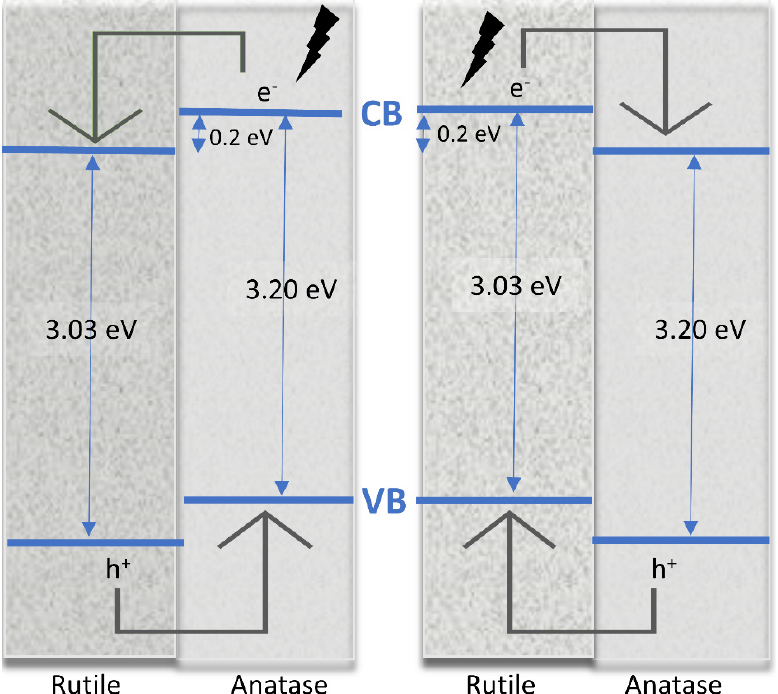
Figure 7. Two valence and conduction band alignment processes for the anatase/rutile interaction. The image on the left presents the transfer of photogenerated electrons from anatase to rutile, and the image on the right displays the recent photoemission measurements from rutile to anatase. Adapted with permission from Nature/Springer/Palgrave, Nature Materials , Band alignment of rutile and anatase TiO 2 , Scanlon D.O. et al., License Number: 5391770708077, 2013